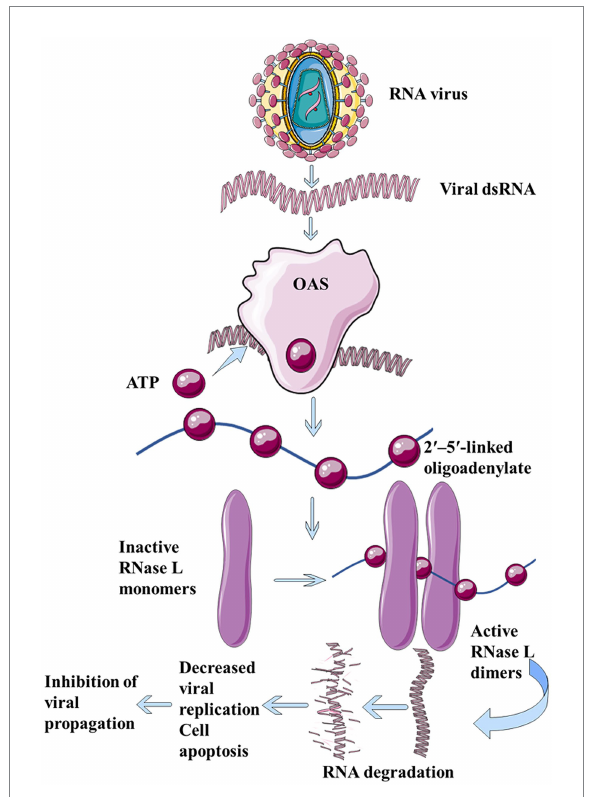
FIGURE 2 The dsRNA produced during virus replication binds to OAS and catalyzes ATP to form 2 ′ , 5 ′ -linked oligoadenylate, which in turn binds to ribonuclease L, thus forming a cross dimer that degrades cell- and virus-derived RNAs, leading to limitation of viral replication, reduction in cell apoptosis, and inhibition of viral